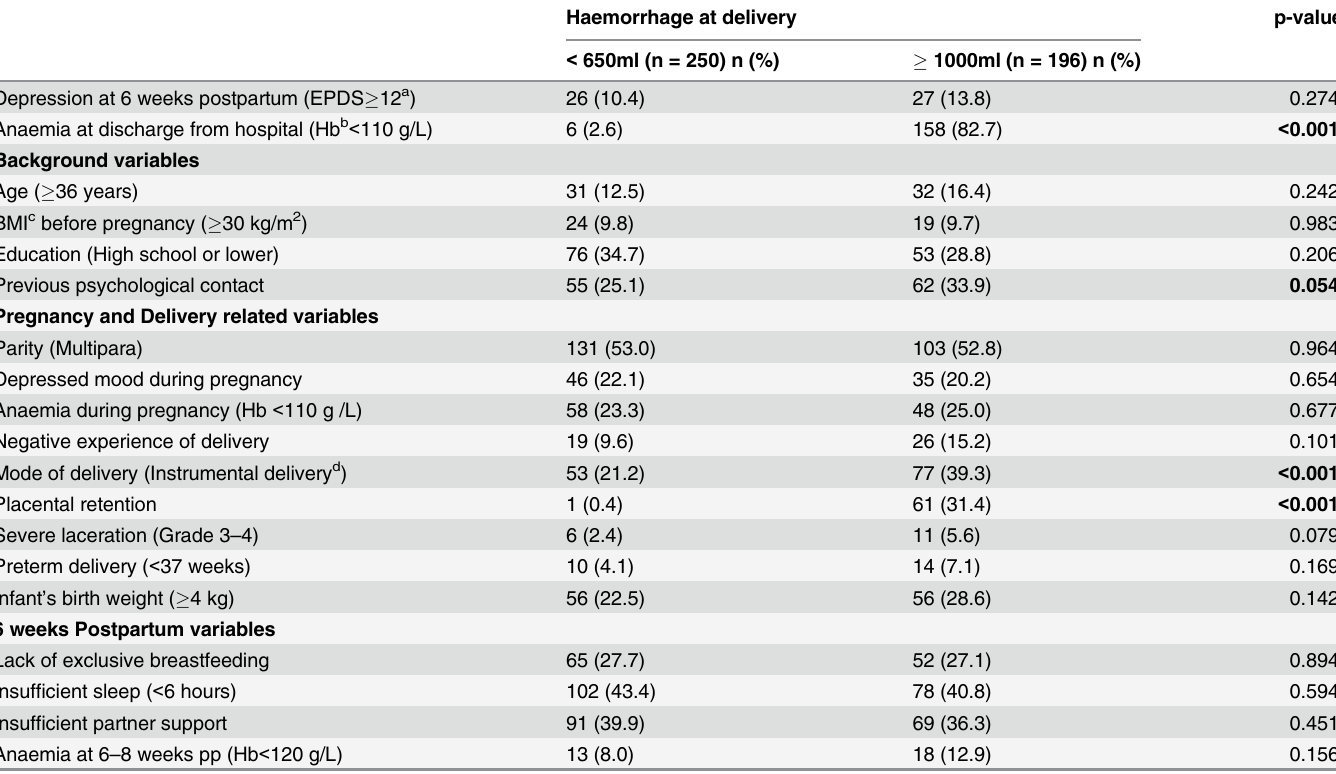
Table 1. Distribution of study participants by demographic, perinatal and clinical characteristics and association with haemorrhage at delivery. Haemorrhage at delivery p-value < 650ml (n = 250) n (%) (cid:1) 1000ml (n = 196) n